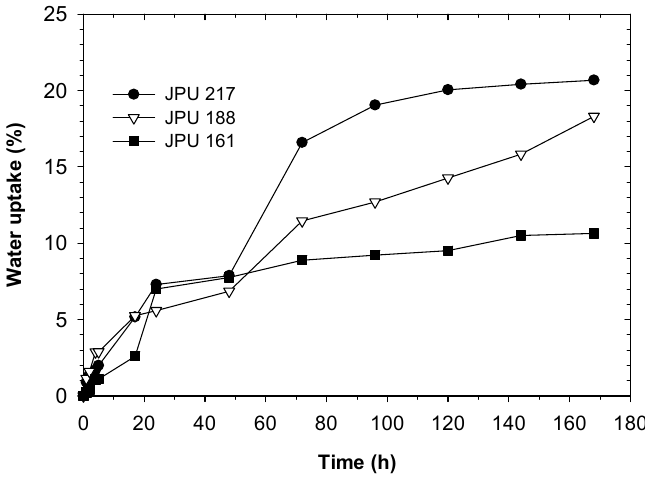
Figure 7. Water uptake of JPU films.